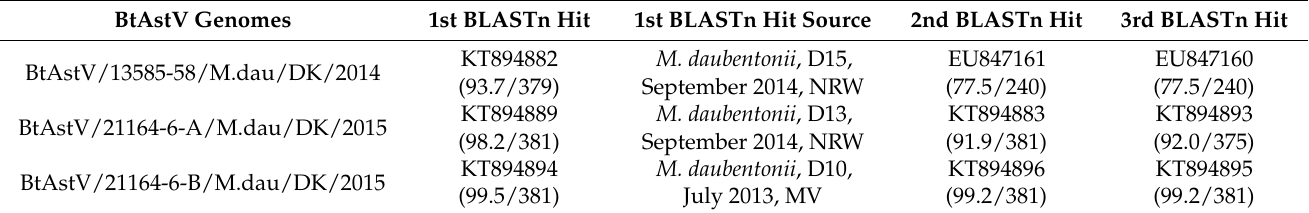
Table 4. The closest matching sequences to the bat astroviruses found in this study are not complete genomes, but partial ORF1ab gene sequences generated by sequencing of RT-PCR products (around 381 nucleotides in length without primers) from the most commonly used assay for detection of astroviruses in bats [46]. This table summarizes the top three identity BLASTn search hits of these short sequences as accession numbers, with % identity/length in parentheses. The 1st BLASTn hits were described previously [45]. Abbreviations used for German regions: North Rhine-Westphalia (NRW); and Mecklenburg-Western Pomerania